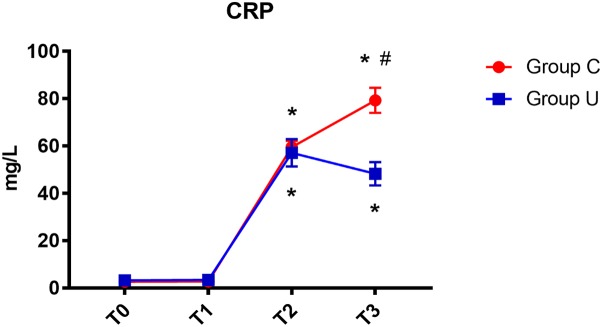
CRP concentrations over time. CRP, C-reactive protein; Group C, the control group; Group U, the ulinastatin group. ∗P < 0.05 from T0 in group C and group U (statistically significant), #P < 0.05 from group U (statistically significant). T0 = before skin incision, T1 = the end of operation, and T2 and T3 = 24 and 72 h postoperative.